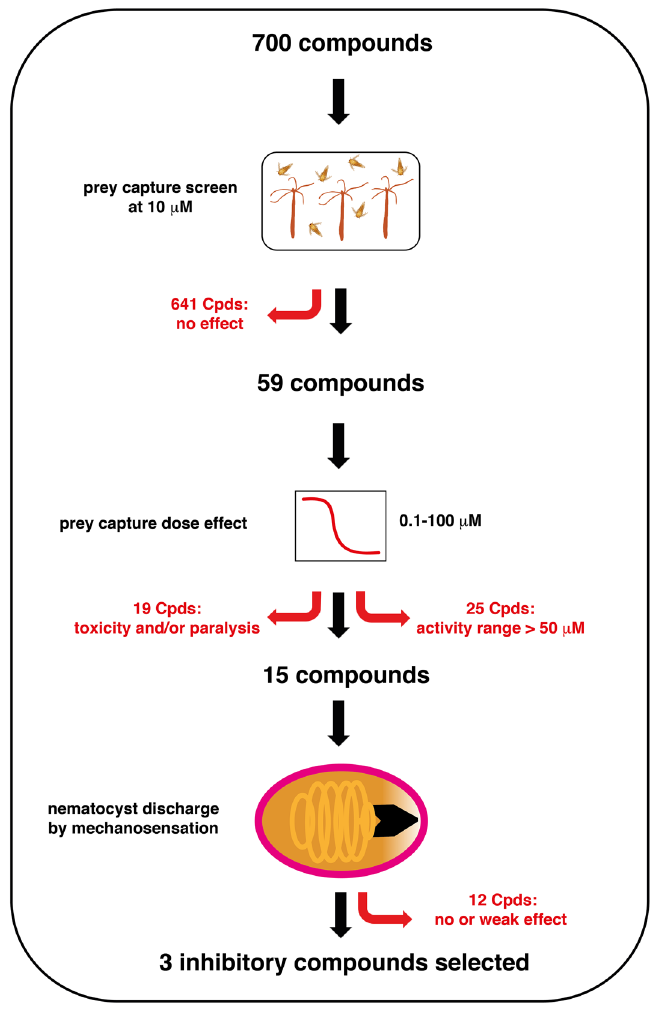
majority of compounds lacking any inhibitory effect at 10 µM were excluded. The remaining 59 compounds were screened for their activity range in the prey capture screen, leaving 15 positive candidates with half- maximal inhibition at 50 µM or lower. Compounds inducing high toxicity (11 compounds) or paralysis (8 compounds) during long-term exposition were excluded at this stage. Toxicity was evaluated using 5